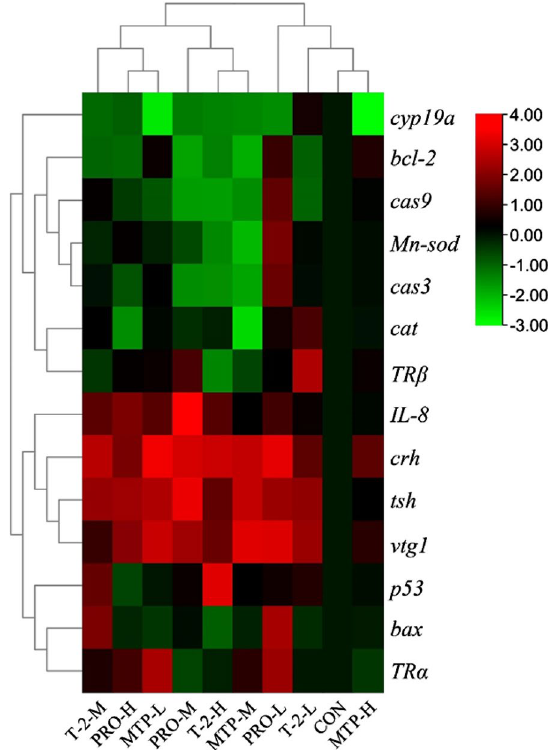
Fig. 7 Heat map evaluation for analyzing throughout variations of mRNA expression. CON control, T-2 T-2 toxin, PRO propiconazole, MTP the mixture of T-2 and PRO, L low concentration, M middle concentration, H high